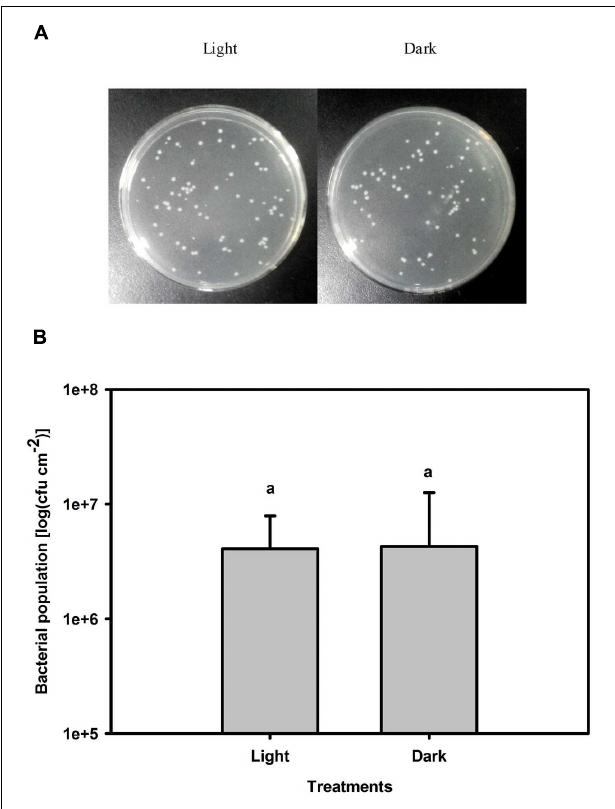
FIGURE 4 | Changes in the Pst population after 3 days of cultivation under light or dark conditions. (A) Pst population was counted on solid King’s B agar plates after appropriate dilution. (B) Pst population was calculated after 3 days cultivation under light (200 µ mol m − 2 s − 1 ) or dark conditions. Means ± SE of four replicates are presented. Different letters above the columns indicate significant differences between treatments at P < 0.05.